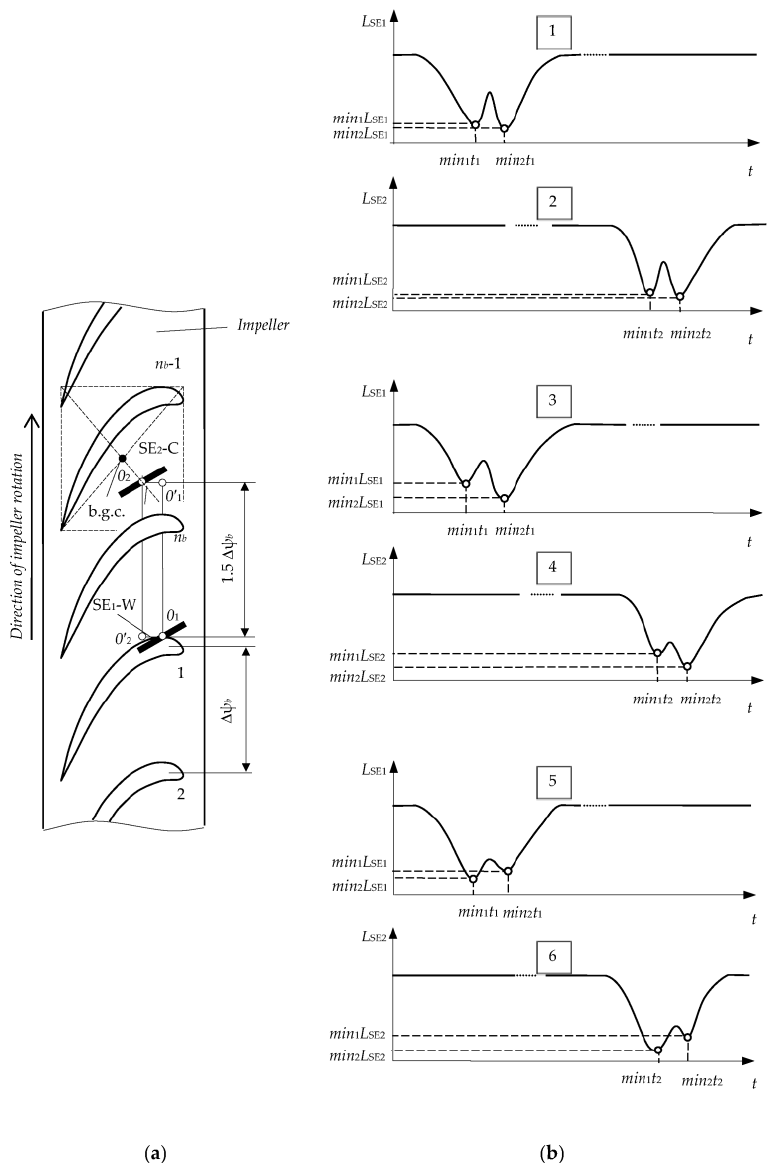
Figure 9. Method 2 : placement of the “distributed cluster” of SCECS on a turbine stator ( a ) and sensors’ SE inductance changes in time ( b ).